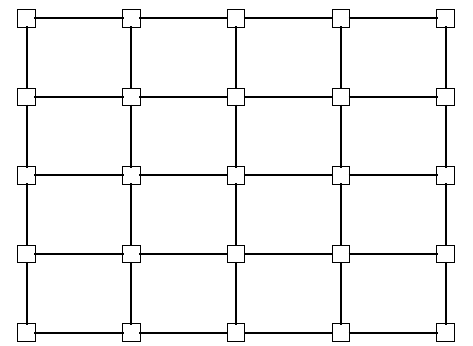
Figure 3: A 2D lattice model partition function is shown as a tensor network on a 5 × 5 square lattice. Each tensor has rank 4 and there are k = 1 links between any pair of adjacent